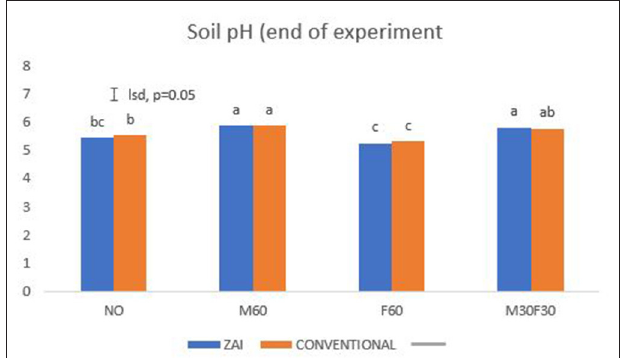
FIGURE 4 | Interaction effect of Zai technology and selected soil nutrient amendment options on Soil pH at the end of the LR20 season. Beg, Beginning of experiment SR18; End, End of experiment LR20; ZNO, Zai with no inputs; ZM60, Zai + Manure; CM60, Conventional + Manure; CNO, Conventional with no inputs; ZF60, Zai + 60kg N ha − 1 ; CF60, Conventional + 60kg N ha − 1 ; ZMF30, Zai + Cattle manure + 30kg N ha − 1 ; CMF30, Conventional + Cattle manure + 30kg N ha − 1 . The error bar denote the least significant